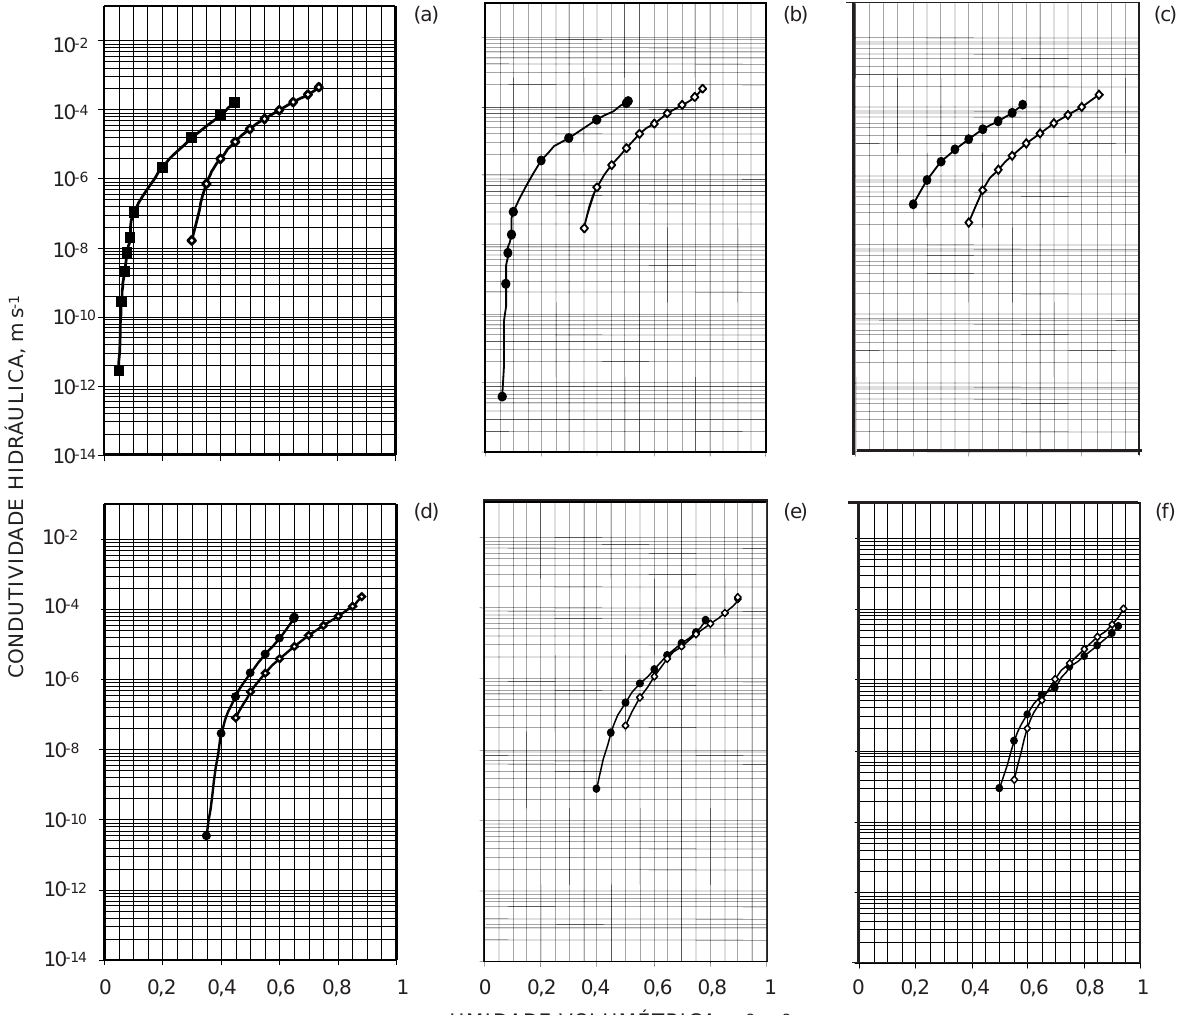
Figura 2. Condutividade hidráulica em função da umidade para as concentrações de hidrorretentor: a = 0; b = 2; c = 4; d = 8; e = 16; f = 32 kg m -3 . Símbolos cheios: Latossolo; símbolos vazios: Areia Quartzosa